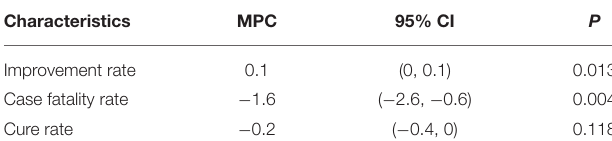
TABLE 2 | Trend analysis of medical service capability.